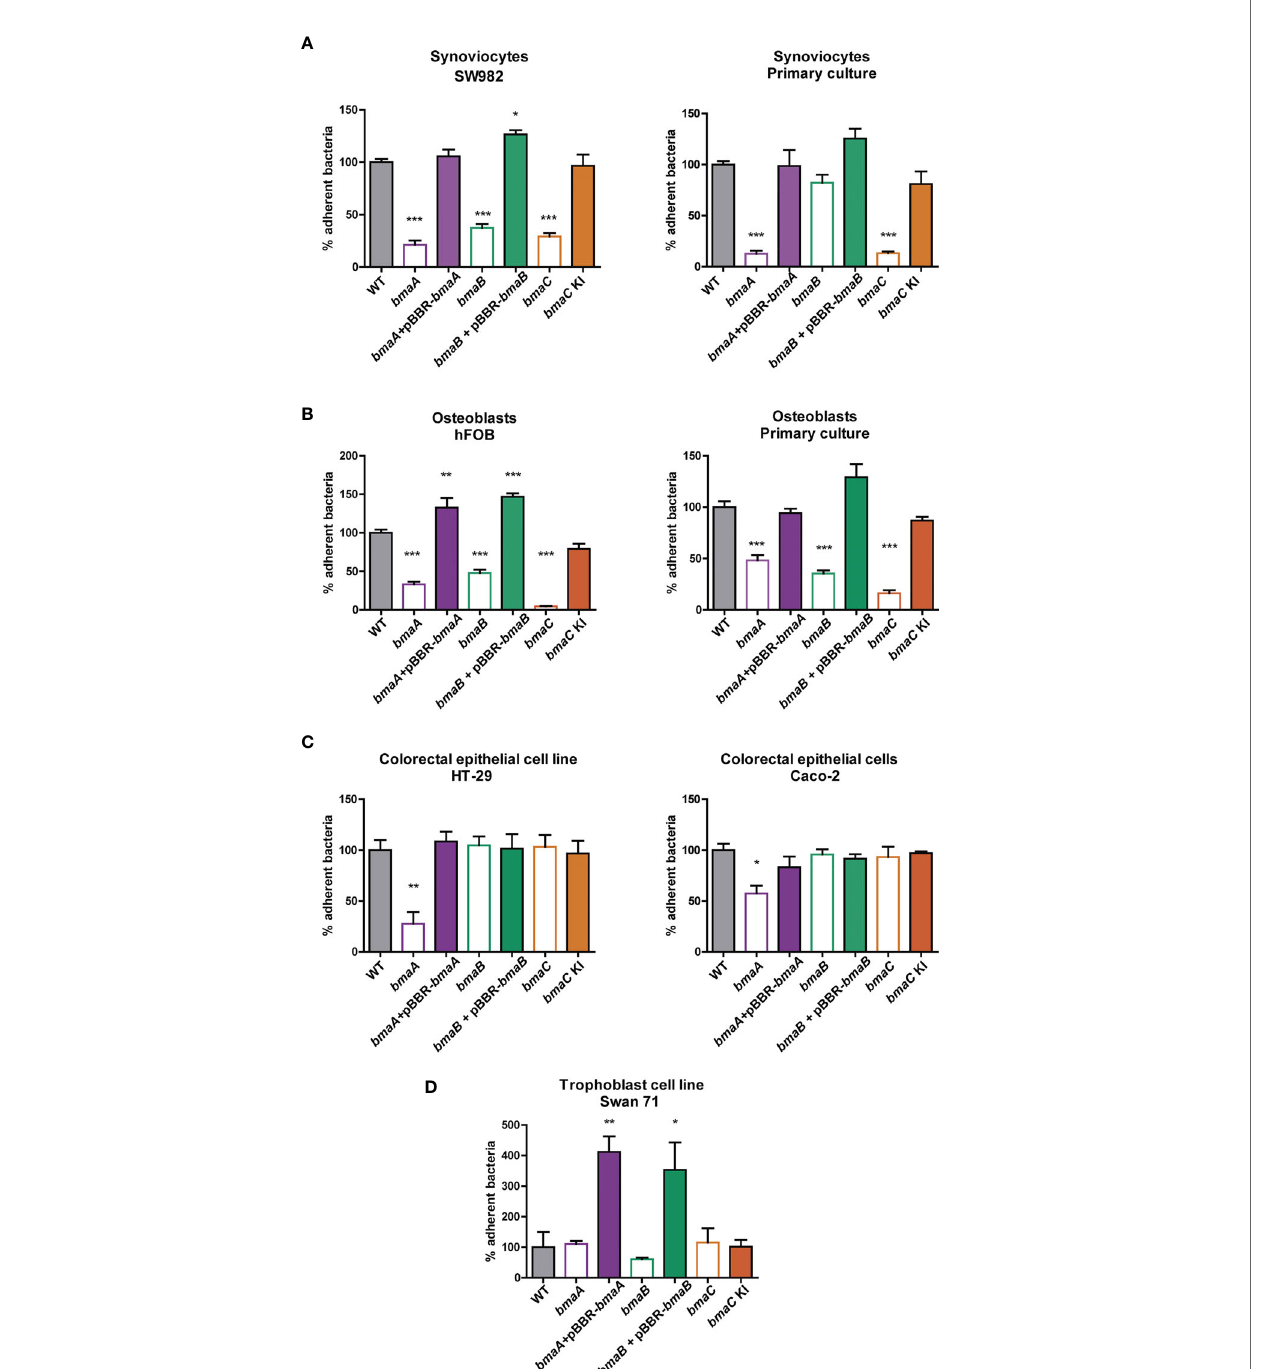
FIGURE 2 | Adherence of Brucella strains to hosts cells. (A) Synoviocyte cell line (SW982) and primary culture, (B) Osteoblast cell line (hFOB) and primary culture, (C) colorectal epithelial cell lines (HT-29 and Caco-2) and (D) trophoblast cell line (Swan71) were infected with B. suis wild type, bmaA :: stops ( bmaA ), bmaB ::Km ( bmaB ), D bmaC ( bmaC ) and the respective complemented strains ( bmaA:: st + pBBR bmaA, bmaB ::Km + pBBR bmaB , and bmaC knock-in – KI-) using a MOI of 1:100. The percentage of adhered bacteria was determined based on the total of bacteria inoculated per well. The percentage of attached bacteria was expressed relative to the control strain, to which the value of 100% was assigned. The results shown correspond to the mean ± standard deviation (SD) of the average of three tests performed in triplicate. The data were analyzed with ANOVA followed by the Tukey´s post hoc test. *, signi fi cantly different from control p < 0.05, **p < 0.005, ***p <